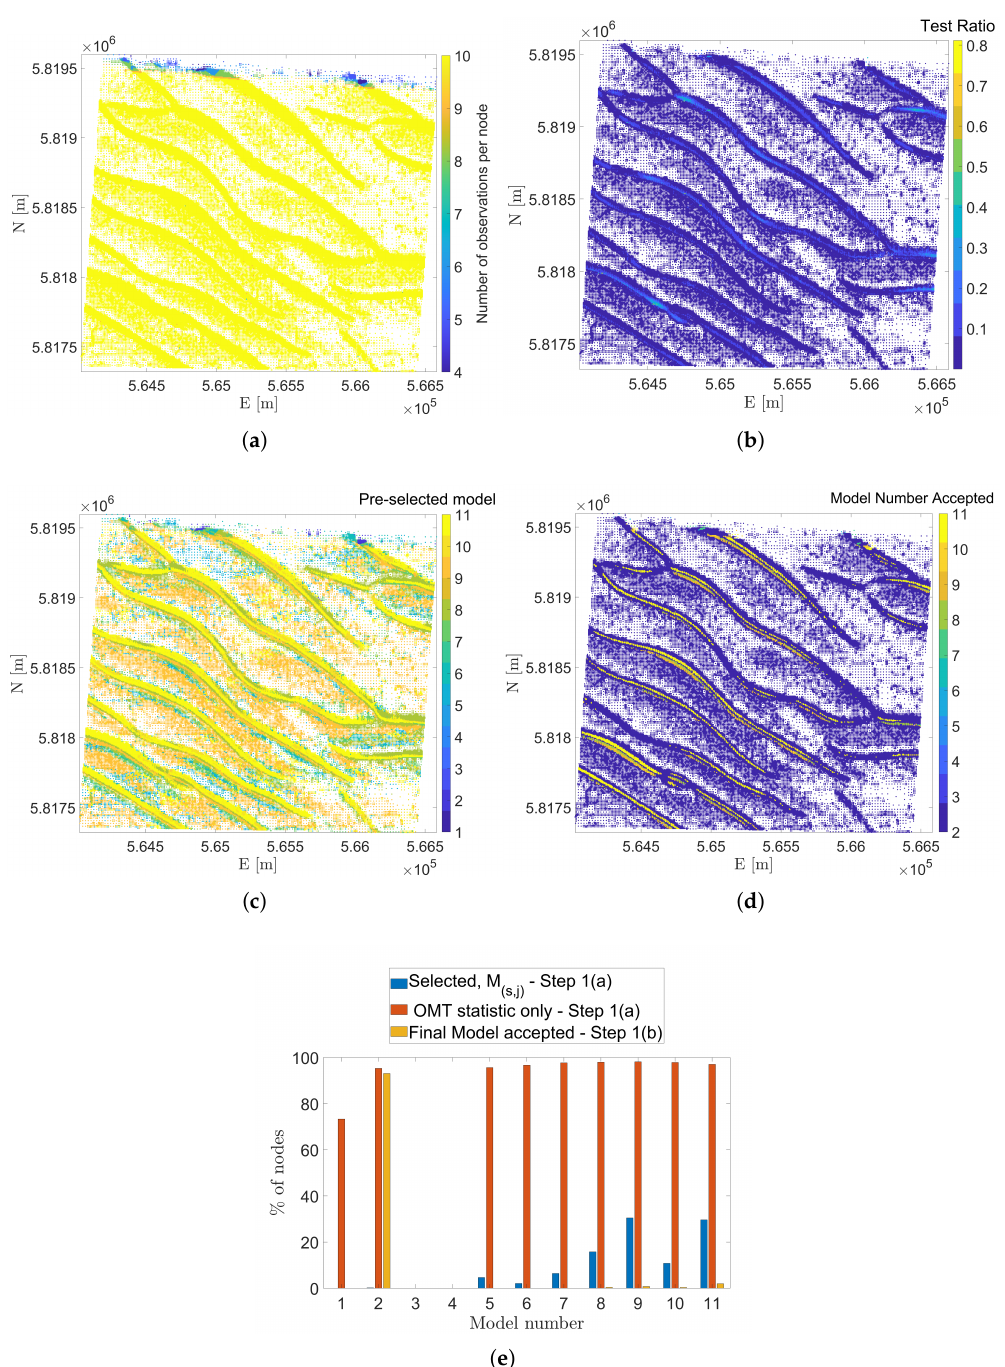
Figure 8. Results after applying testing procedure outlined in Figure 4. Showing per node ( a ) Number of observations, ( b ) Test Ratio values, R ( i , j ) for selected models M ( s , j ) after step 1(a), ( c ) Selected Models, M ( s , j ) per sub-area after step 1(a), ( d ) Final accepted models after applying step1(b) and ( e )% of nodes and corresponding models accepted under step 1(a) and step 1(b) resulting in M ( s , j ) , and the final selected models respectively. The most frequently acceptable models under the OMT statistic only is also